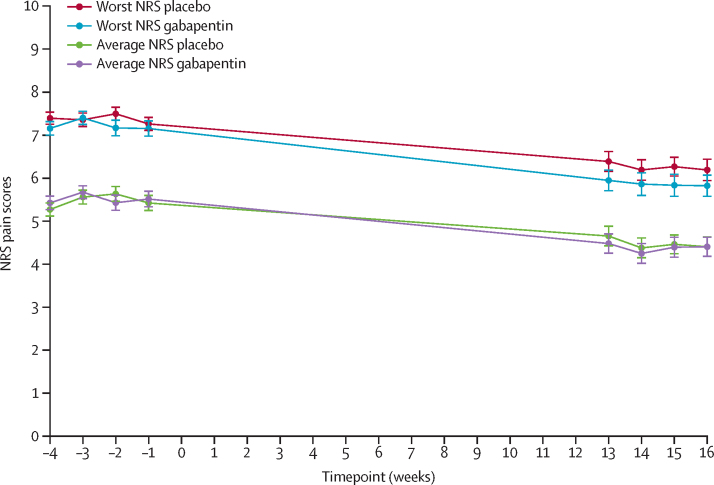
Longitudinal plot of primary outcome measurements in each trial groupError bars indicate the SE. NRS=numerical rating scale